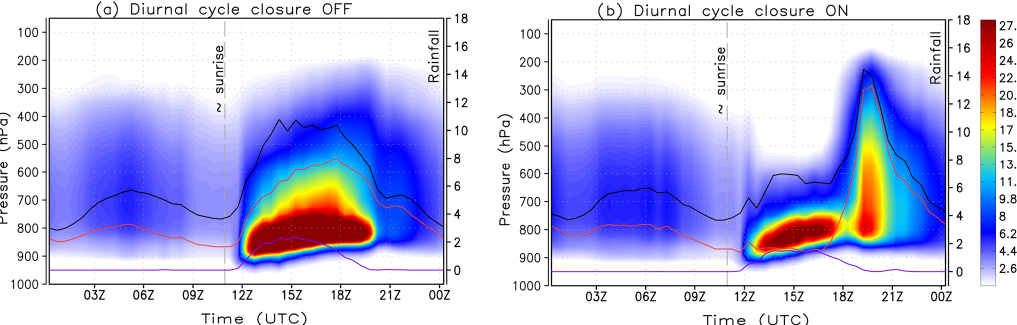
Figure 9. Color shading is the time average of the diurnal cycle of the total vertical mass flux of the three convective modes: shallow, congestus, and deep (10 − 3 kgm 2 s − 1 ). The rainfall is depicted by graphic lines: black, red, and purple represent the total precipitation and the convective part from deep and congestus plumes, respectively. The scale for rainfall appears on the right vertical axis (mmd − 1 ). Panel (a) represents the results without the diurnal cycle closure, and panel (b) is